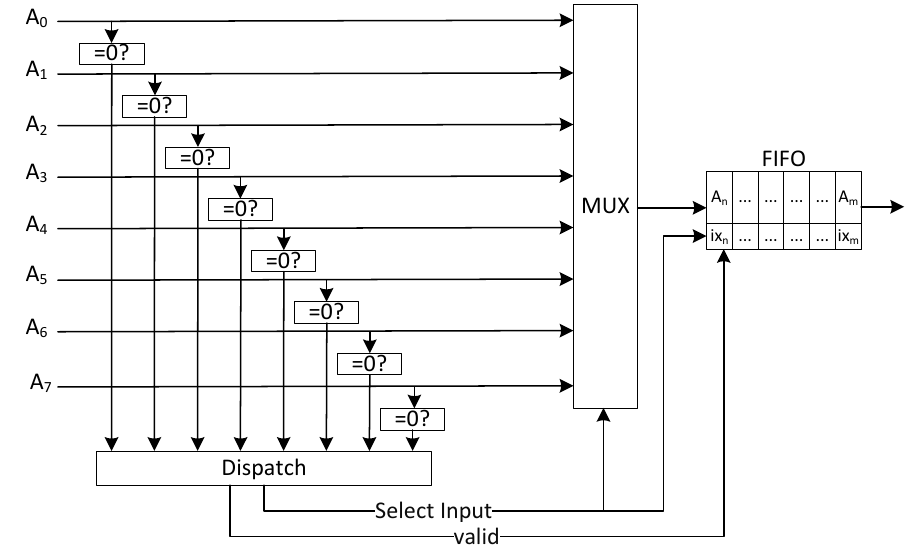
Figure 8. Architecture of the dispatcher for the zero-skipping